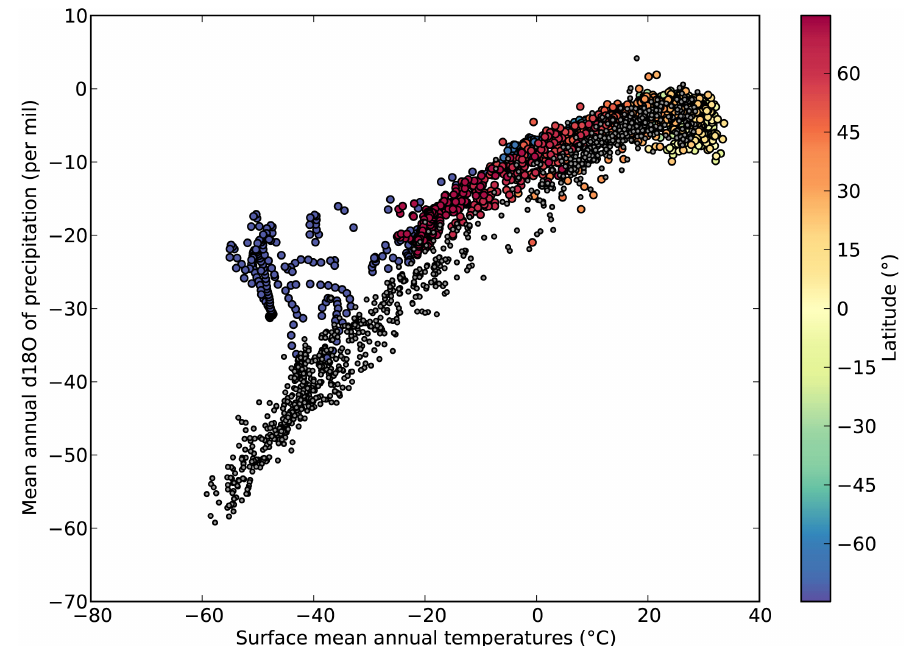
Fig. 2. Annual δ 18 O-temperature relationship in i LOVECLIM compared to the GNIP database (IAEA, 2006) and Masson-Delmotte et al. (2008) database for Antarctic snow isotopic composition. So-called “Dansgaard relationship”. Coloured circles are from i LOVECLIM: their colour indicating latitude and grey dots are the observations.